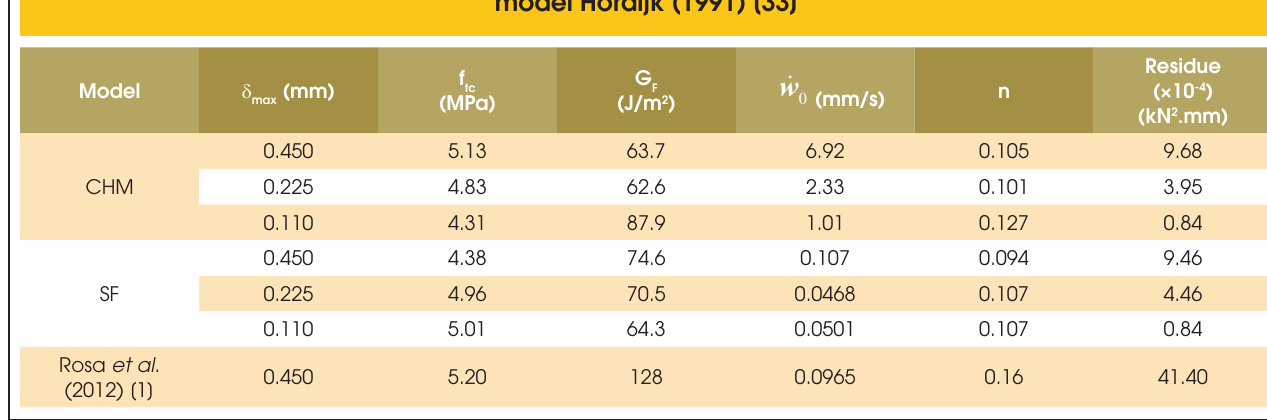
Table 6 – Results for the simultaneous fit of the viscous-cohesion using the